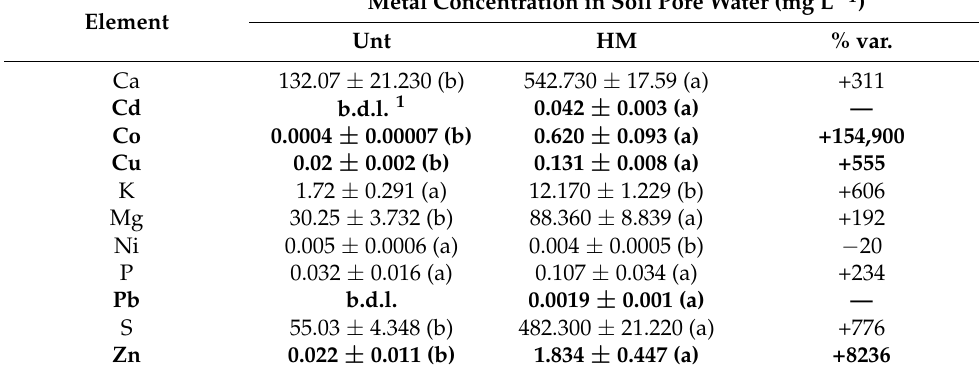
Table 2. Metal concentrations (mg L − 1 ; ± SE; n = 4) in soil pore water extracted from pots of uncontaminated controls (Unt) vs. HM-contaminated treatment, and % variation vs. Unt. Letters in brackets indicate significant differences between treatments (Newman–Keuls test, p ≤ 0.05). Elements artificially added to the soil are highlighted in bold.